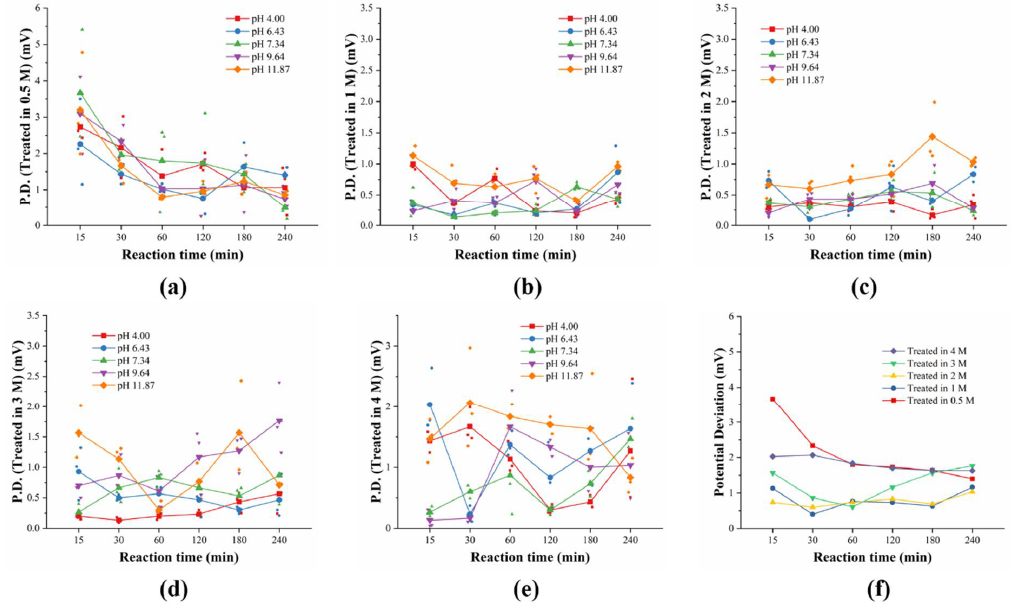
Figure 9. The influences of the fabrication parameters and pH levels on the potential deviation (P.D.) of the sensitive electrodes treated in ( a ) 0.5 M, ( b ) 1 M, ( c ) 2 M, ( d ) 3 M, ( e ) 4 M and ( f ) the potential deviation of each electrode.